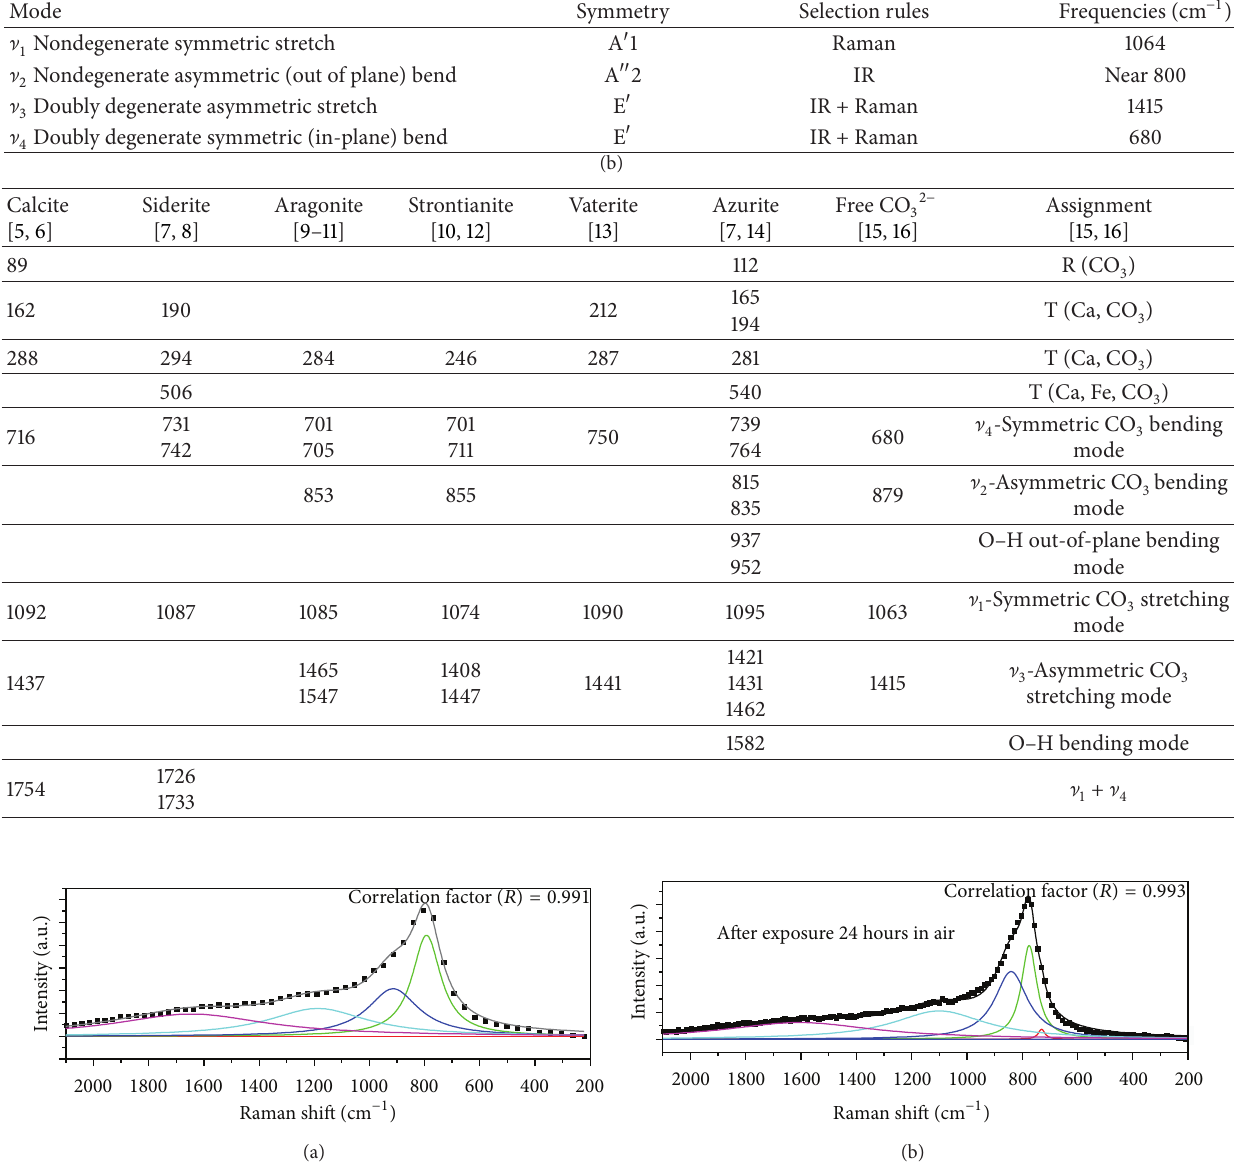
Figure 9: Raman spectrum of calcium hydroxide obtained heating at 1000 ∘ C CaCO 3